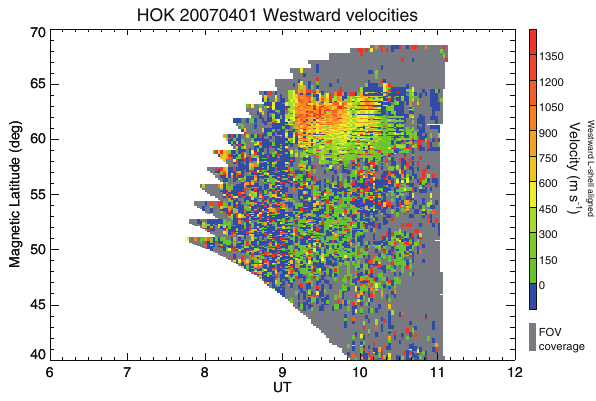
Fig. 1. MLAT-time diagram of westward flow amplitude at 20:00MLT on 1 April 2007. The westward flow amplitude is es- timated assuming the L-shell aligned convection flow.